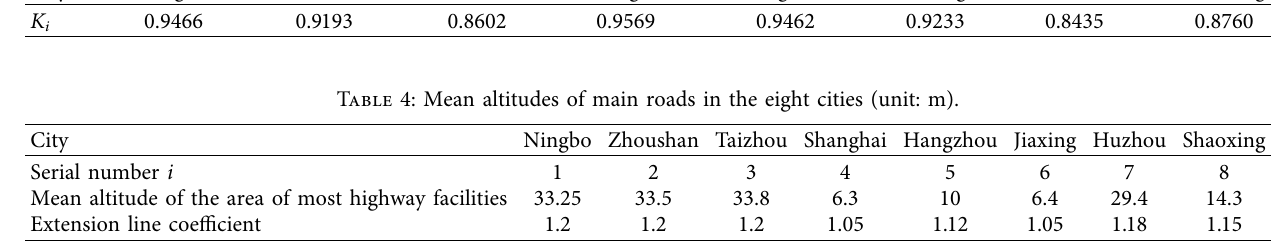
Table 5: Straight-line distance d